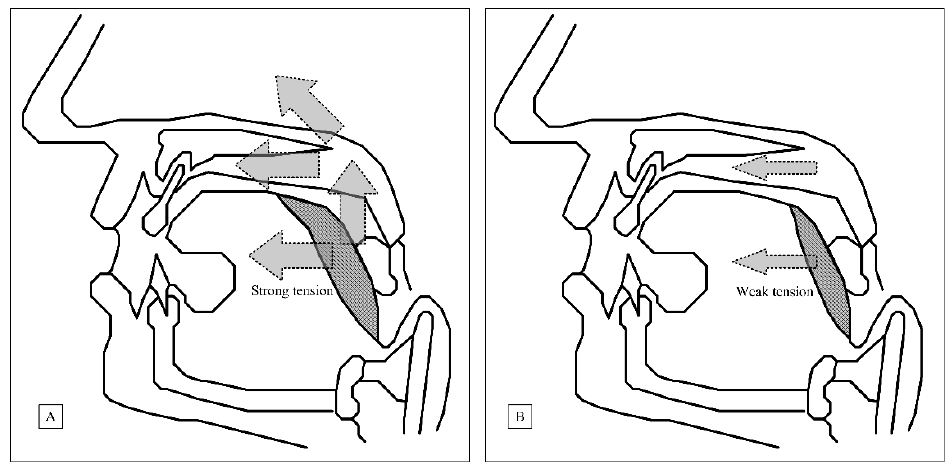
Figure 3. The palatal suture mechanism of BRP plus TORSTBR ( A ) and UPPP plus TORSTBR ( B ) techniques.